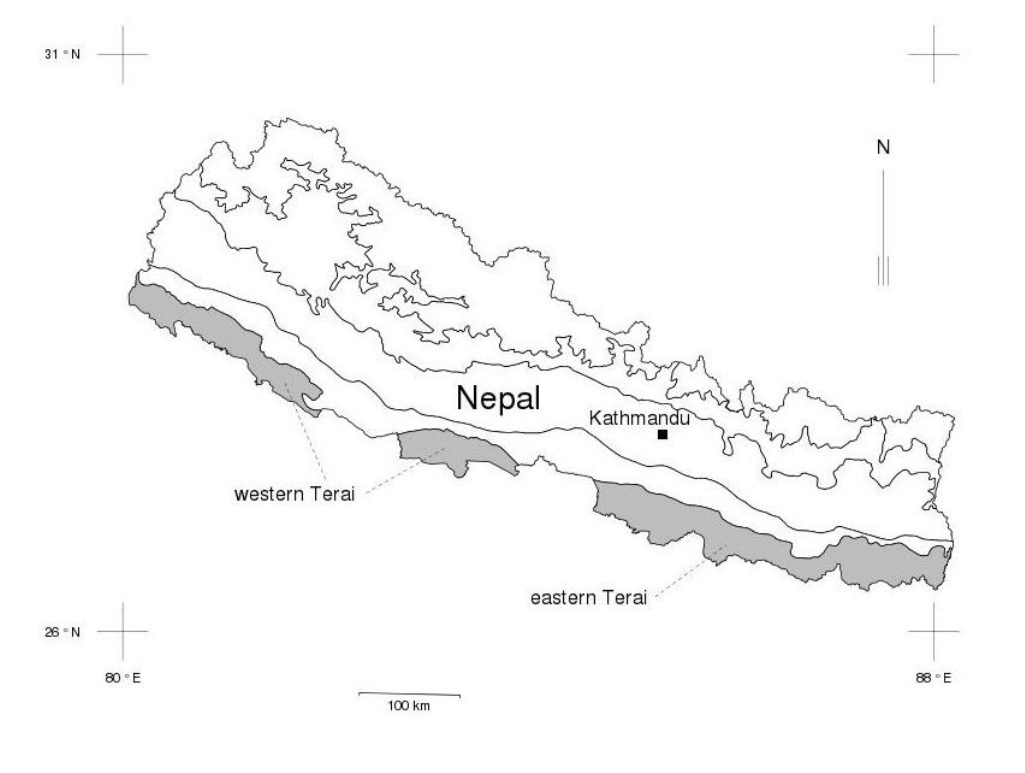
Figure 1. Map of Nepal with borders of the physiographic zones. The study area, i.e. , Terai, is denoted by the grey-fill color.